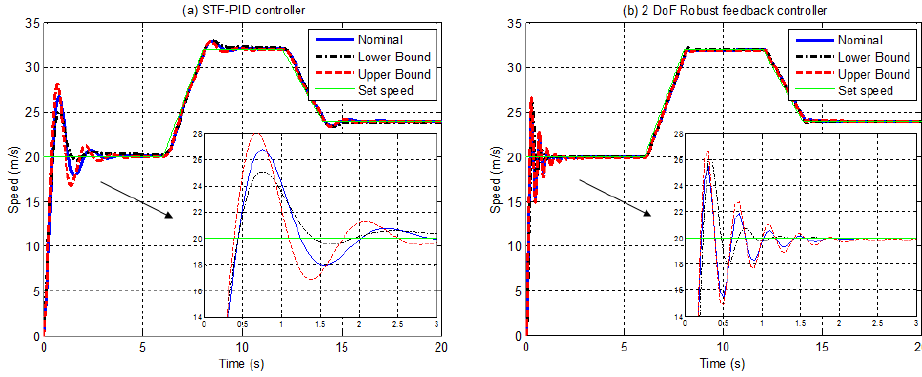
Figure 9. Wide range operation response for the HEV speed control ( a ) with STF-PID and ( b ) with the 2-DoF robust controller.